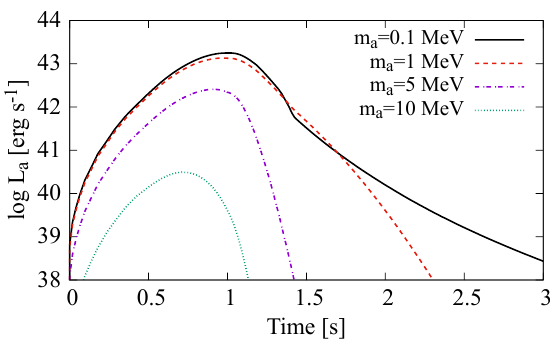
Figure 2. The ALP luminosity as a function of time after the ignition [7]. The ALP-photon coupling is fixed to g 10 = 1.